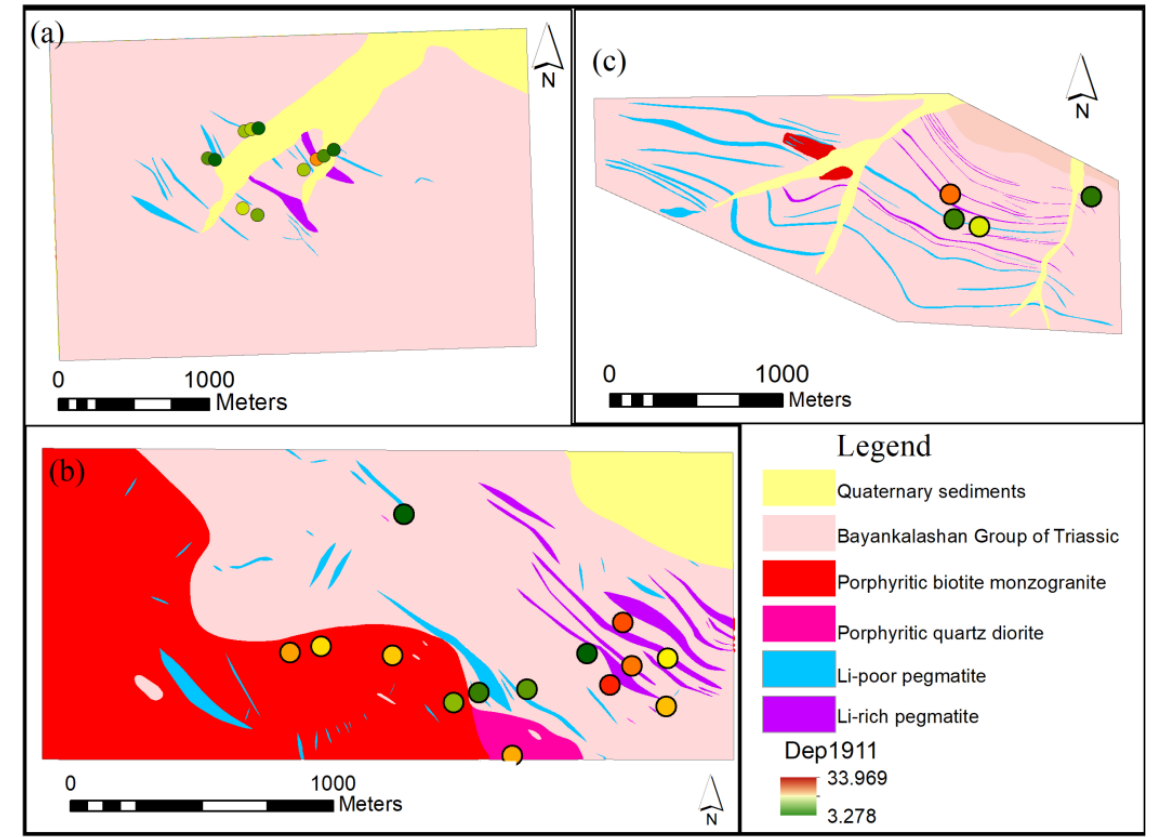
Figure 9. The spatial distribution of the characteristic parameters: ( a ) Akesayi mine, ( b ) the 509 mine, ( c ) Longmengshan mine).